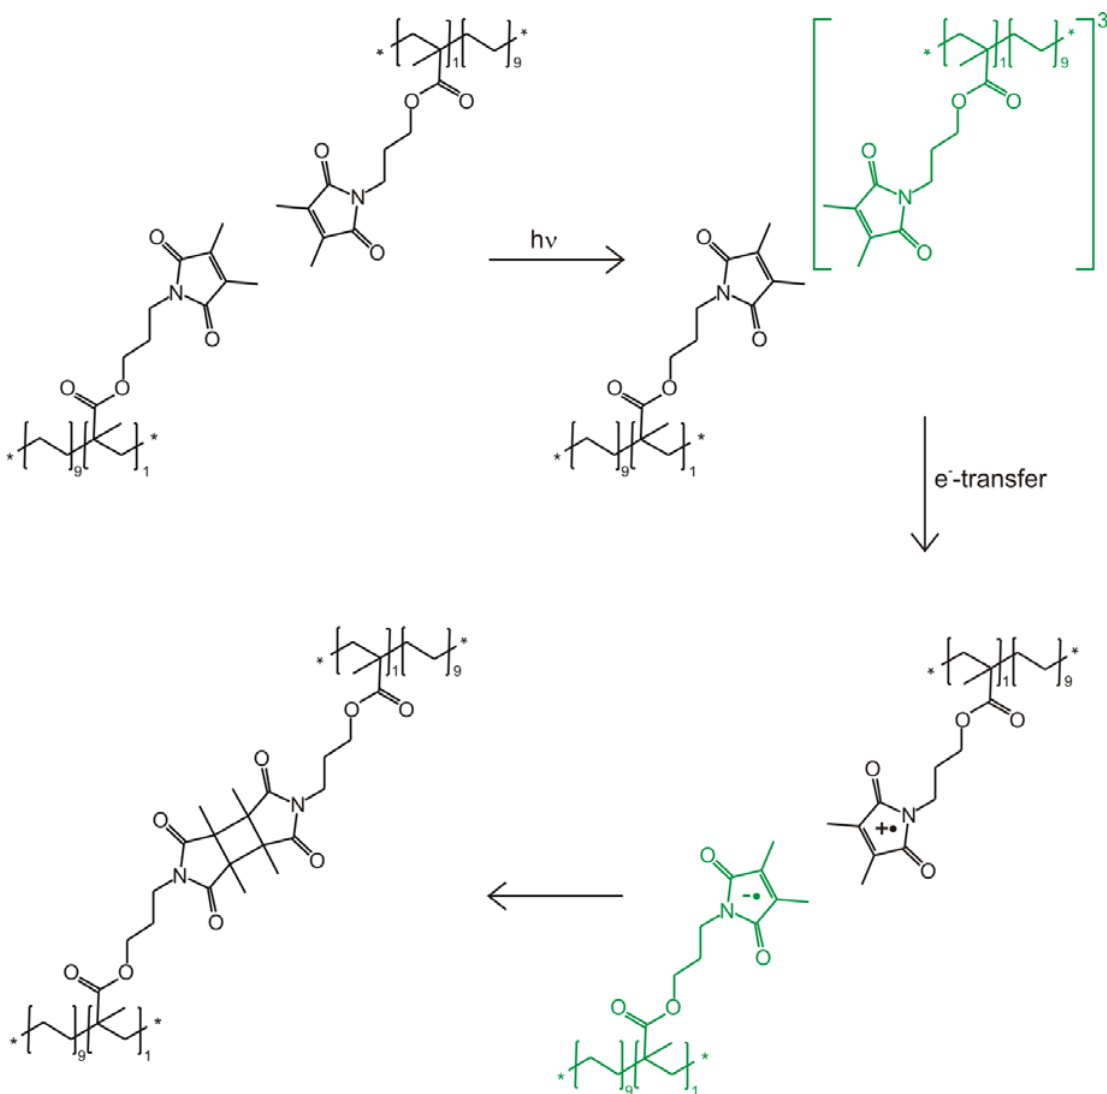
Figure 6. Mechanism for photocrosslinking of PEMAA modi fi ed with 3-hydroxypropyldimethylmaleimide. Upon excitation to the bright singlet state some population is transferred to the triplet state by intersystem crossing. Electron transfer leads to quenching of the triplet population and allows spectroscopic identification of the maleimide anion. Photocrosslinking occurs by recombination of the ions to the dimer. Our spectroscopic results do not exclude a parallel reaction path via direct cross linking of favorably oriented maleimides in the excited singlet state, see text. Transient species which were detected spectroscopically (triplet state, radical anion) are marked in